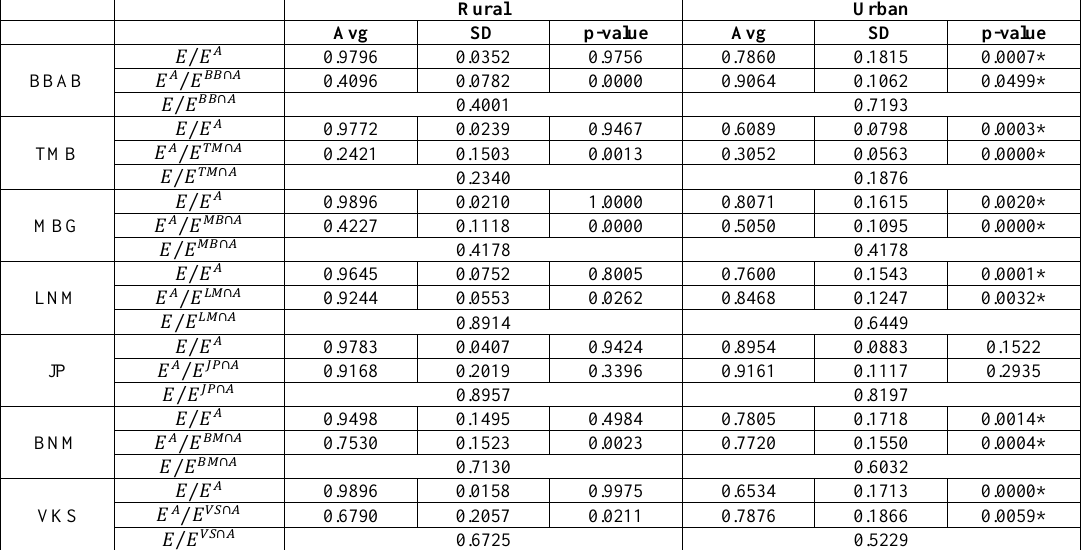
Table 7. The average impact of university factor on 𝐸 𝐴 and its